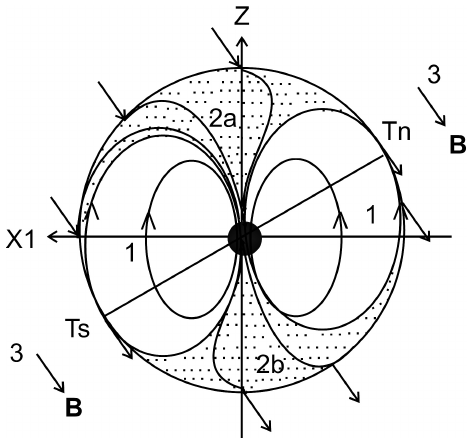
Fig. 1. The meridional cross section of the spherical magnetosphere for southward IMF. The region marked 1 indicates closed field lines, the regions 2a and b (dotted) indicate open field lines of the northern and southern polar caps.